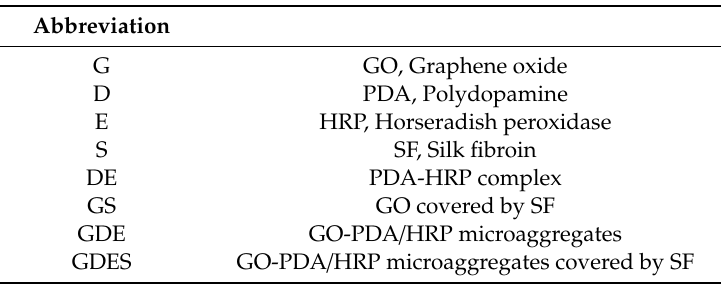
Table 1. Abbreviation of